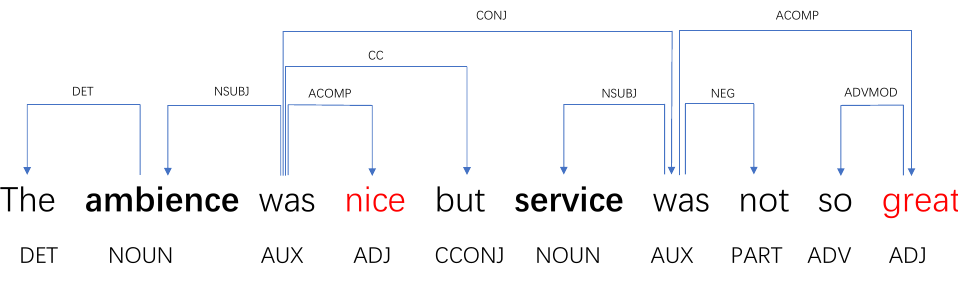
Figure 1. Syntax dependency